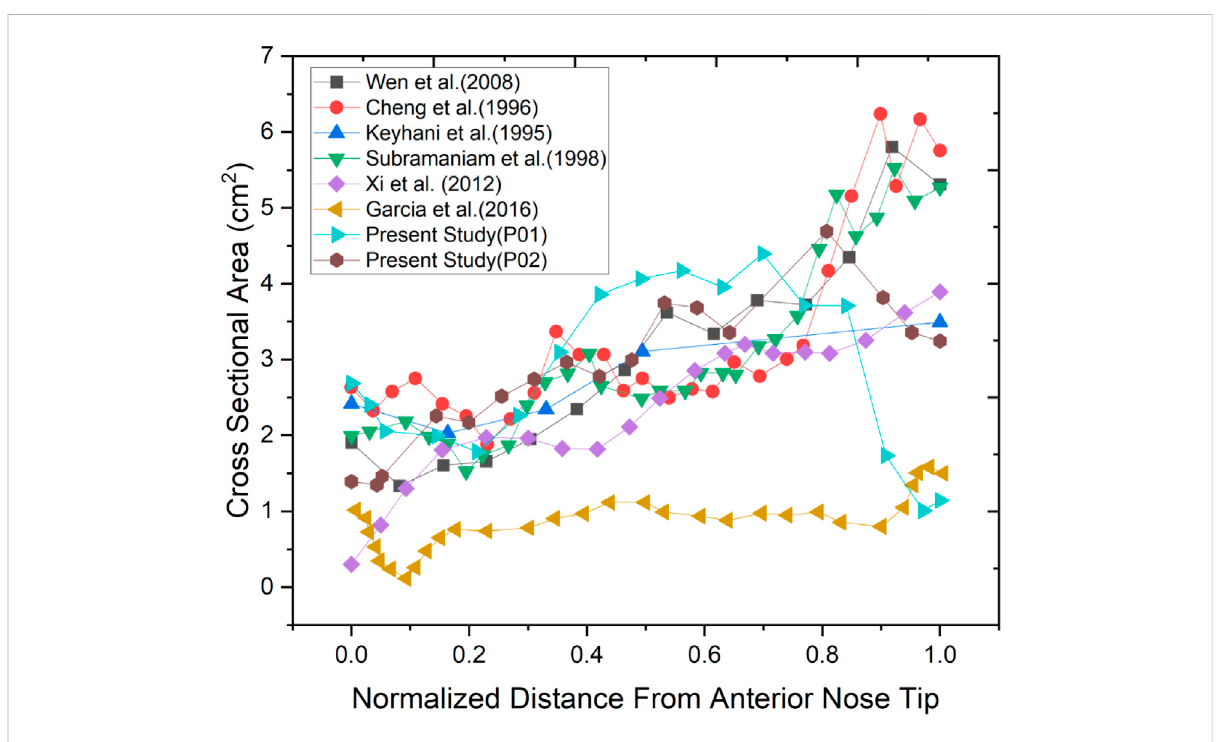
FIGURE 3 Comparison of cross-sectional areas with the